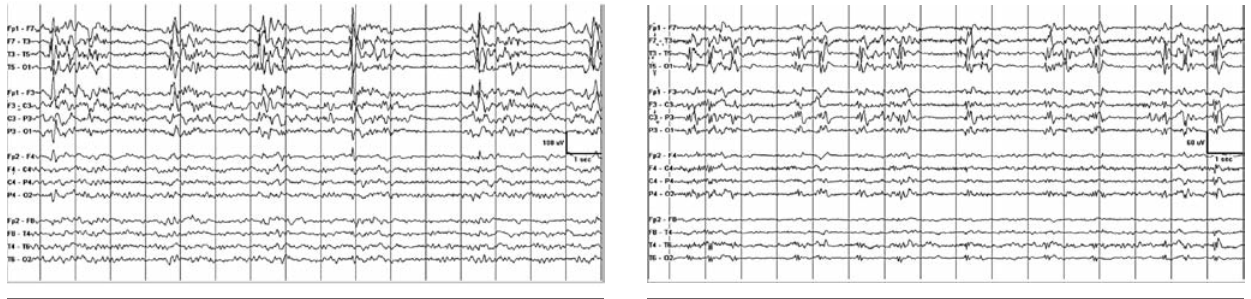
cortical hyperexcitability.